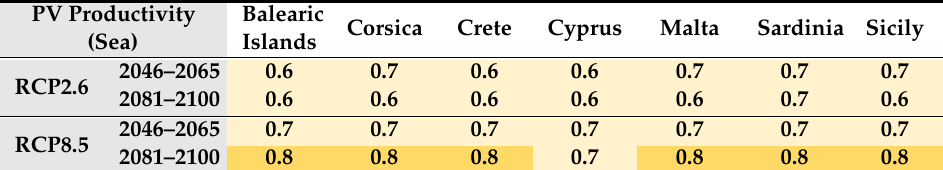
Table 7. As for Table 6, but this is constructed for PV productivity over the sea. Domains considered for the calculations are shown in Table